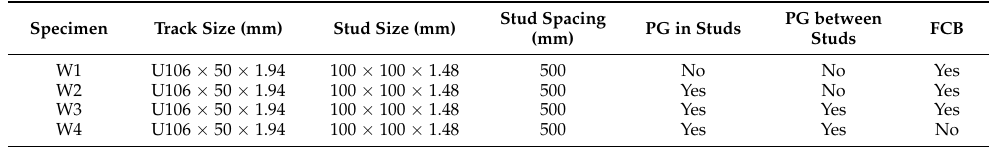
lies in the difference in sections, and the design information of specimens is listed in Table 1. Specimen W1 is a wall with a hollow section, specimen W2 was covered with wall sheathings and filled with PG in the studs only, and specimen W3 was covered with wall sheathings and filled with PG in the studs and between studs. The only difference between specimens W3 and W4 is that specimen W3 was covered with wall sheathings, while specimen W4 was not. All specimens were assembled with a width of 1300 mm and a height of 2500 mm. The wall studs were fabricated from cold-formed thin-walled square steel tubes with a dimension of 100 × 100 × 1.48 mm, and the spacing of wall studs is 500 mm. The top and bottom tracks were made into a U-shaped section with a dimension of 106 × 50 × 1.94 mm. To fully dissipate the water of PG and achieve the strength of PG, pre-punched circular holes spaced at 50 mm were opened along the length of the top and bottom tracks. The steel strips spaced at 500 mm were arranged along the height of the wall, and the dimension of the strip is 1300 × 60 × 1.94 mm. Wall sheathings were manufactured with 8 mm thick fiber cement boards (FCB), fixed on the CFS frames using ST4.2 × 35 mm bugle-head self-drilling screws. The FCBs were cut into different sizes according to the installation requirements. Finally, a vertical seam and a horizontal seam were formed between the installed FCBs. The installation spacing of the screws in horizontal and vertical directions is 122 mm and 150 mm, respectively. The configurations and dimensions of all specimens are illustrated in Figure 1. Table 1. Design parameters of specimens.